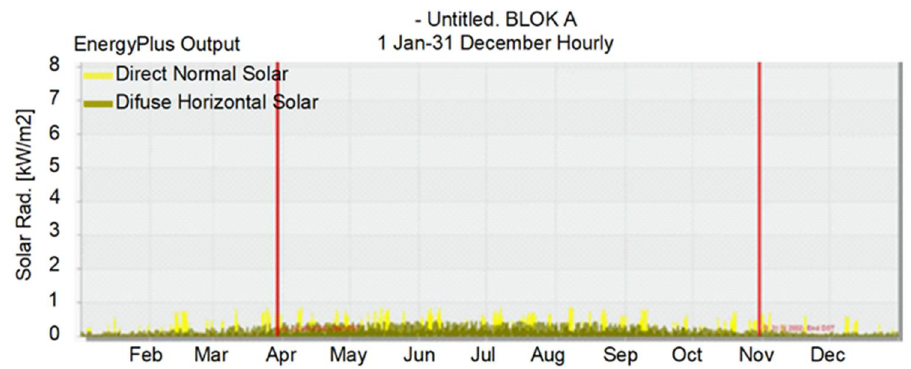
Figure 11. Direct and diffuse radiation in the solved locality throughout the year.